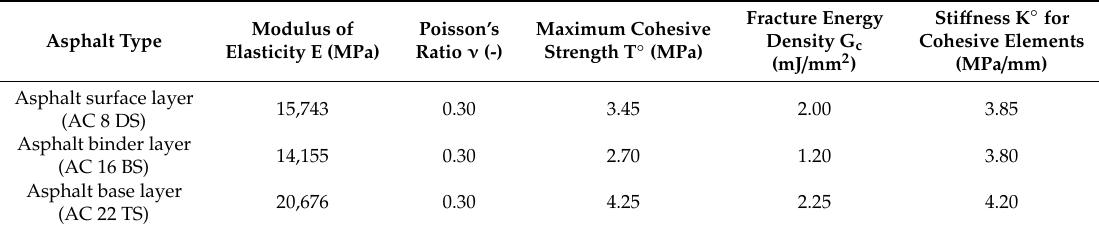
Table 2. Material parameters at + 5 ◦ C.